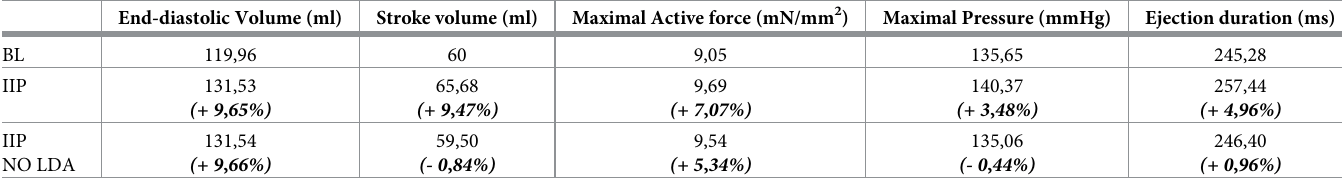
Table 1. Quantitative comparison of the BL, IIP and IIP NO LDA simulations. See text for detailed explanations. End-diastolic Volume